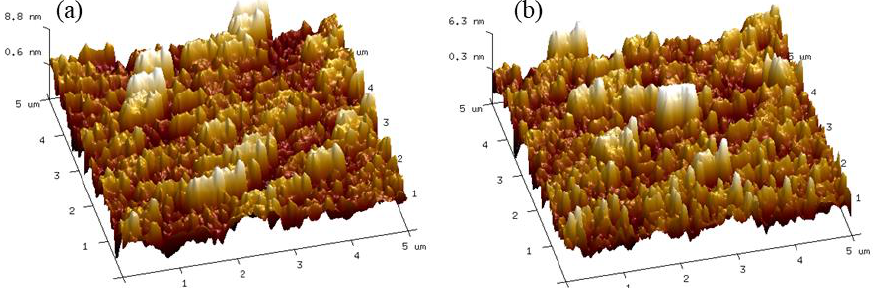
Figure 3. This The 3D atomic force microscopy (AFM) images of the samples produced with various sputtering gases ( a ) Ne ( b ) Ar.